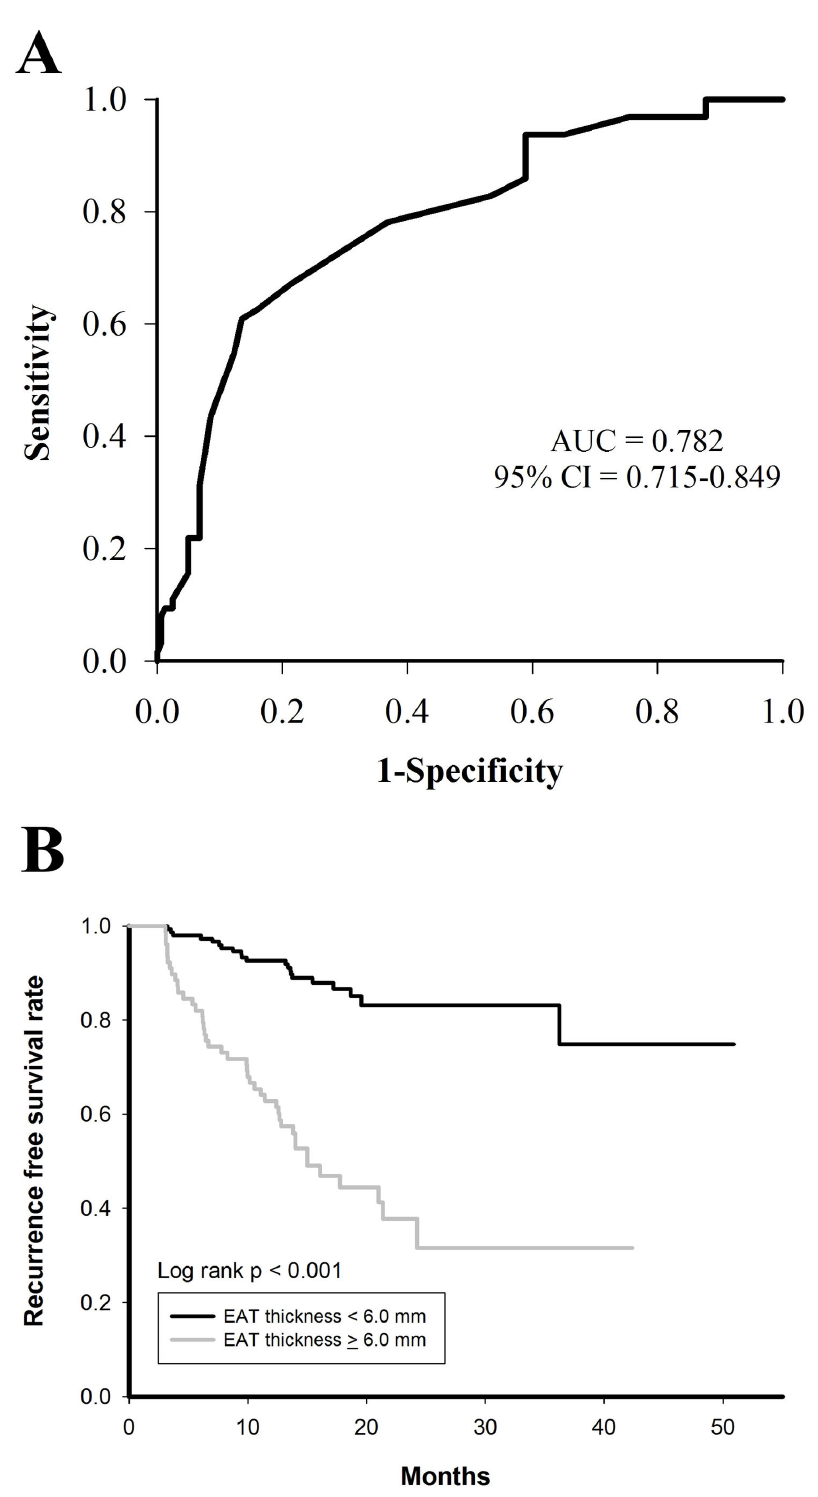
Figure 3. ROC curve and Kaplan-Meier analysis of EAT thickness in predicting recurrence after catheter ablation of PAF. At the cutoff value of 6.0 mm identified by the ROC curve (A), PAF patients with an EAT thickness of > 6.0 mm had a higher recurrence rate of atrial arrhythmias after catheter ablation (B). EAT = epicardial adipose tissue; PAF = paroxysmal atrial fibrillation; ROC = receiver-operator characteristic. doi: 10.1371/journal.pone.0074926.g003 PLOS ONE |